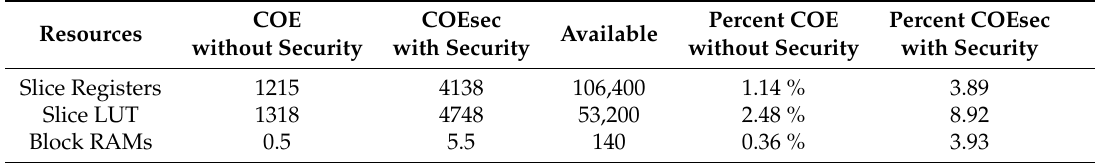
Table 1. Field Programmable Gate Array (FPGA) resources used for the COEsec module implementation.